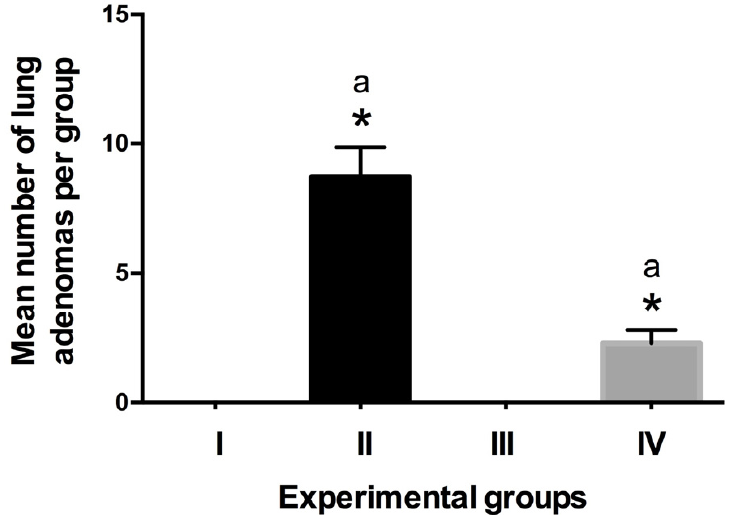
Figure 4. Quantitation of developed adenomas per group. No tumors were observed in group I (control) and group III (vanadium). In group II (urethane), the tumors were larger than in group IV (urethane-V group). N = 10, values are expressed as the mean number of adenomas ± SEM (ANOVA p ≤ 0.05 Tukey’s post hoc). * Statistically significant differences versus group I; a: statistically significant differences between group II and IV.